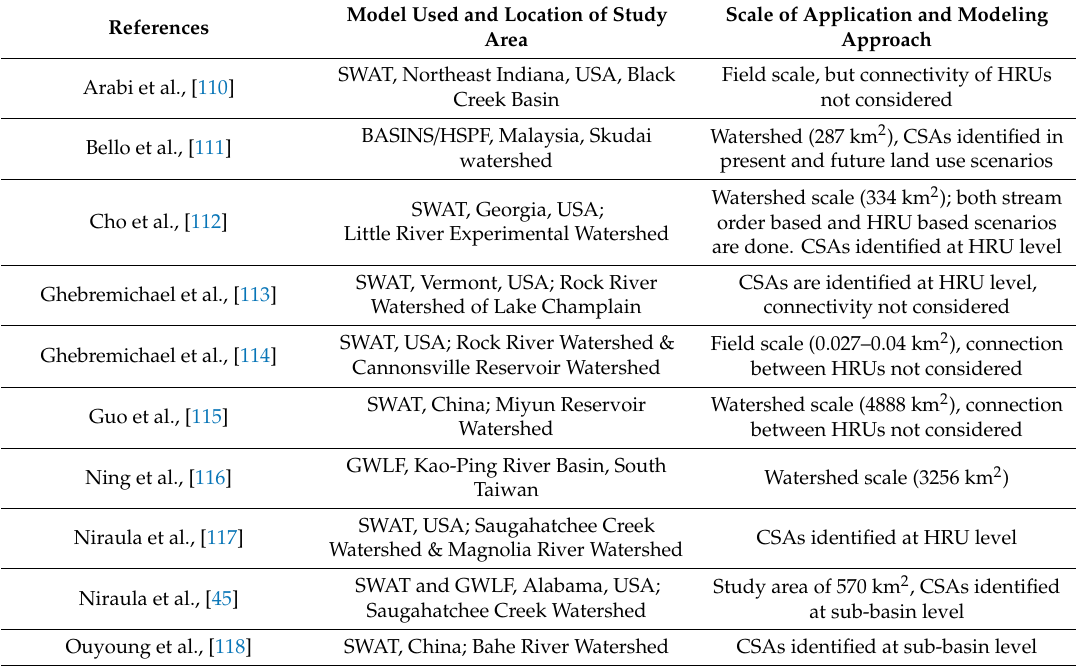
Table 1. Overview of the top five hydrologic and water quality (HWQ) models applied to identify critical source areas